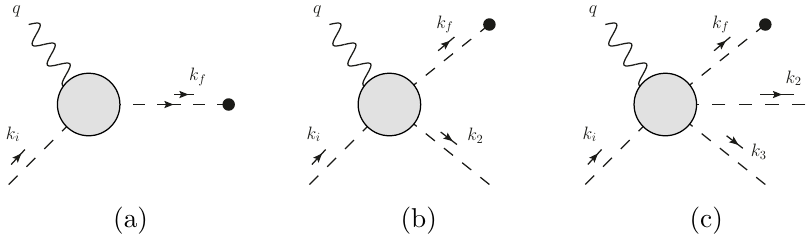
Figure 6 . Examples of hard kinematics. Graph (a) represents handbag kinematics. Graph (b) is 2 2 kinematics, which can represent, for instance, the (cid:12)rst non-vanishing contribution when we ! specialize to massless pQCD graphs at large transverse momentum. Graph (c) is 2 We remark that in general, in Graphs (a), (b) and (c) the dashed lines may represent groups of particles, such as those making up a gauge